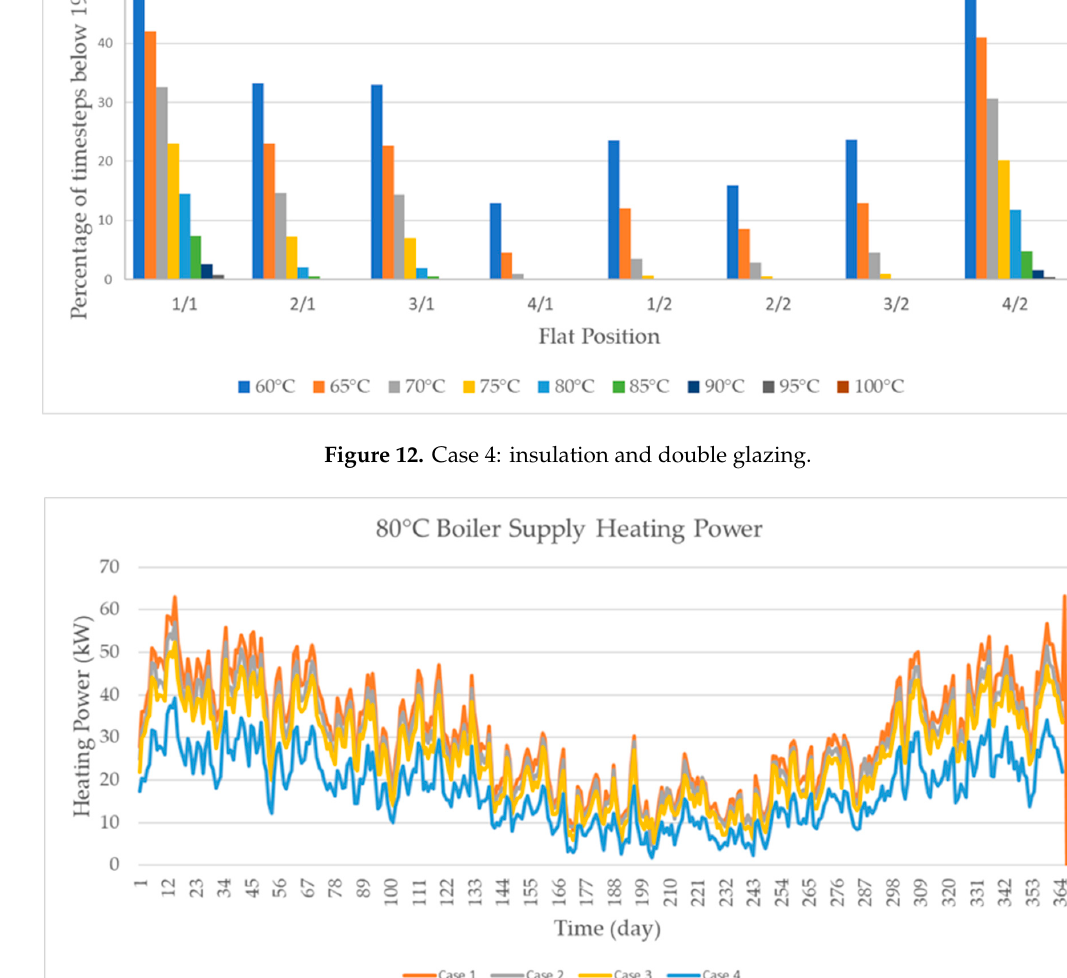
Table 5. Minimum supply temperature.